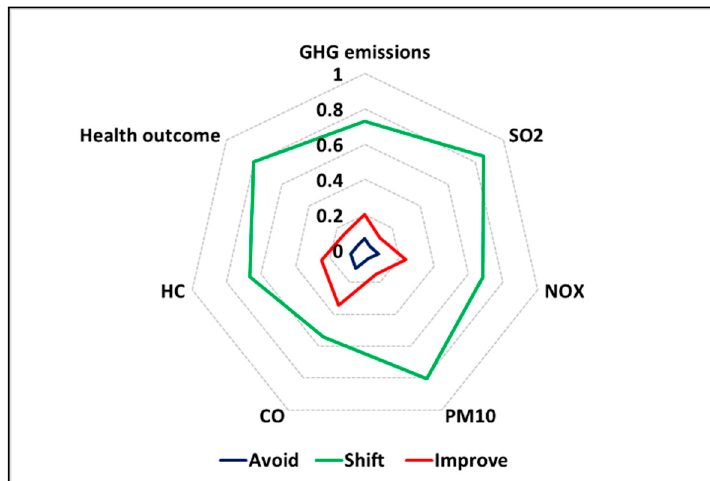
Figure 10. Impact assessment of the TTMP (Max = Total amount of each expected co-benefits, Min = 0).